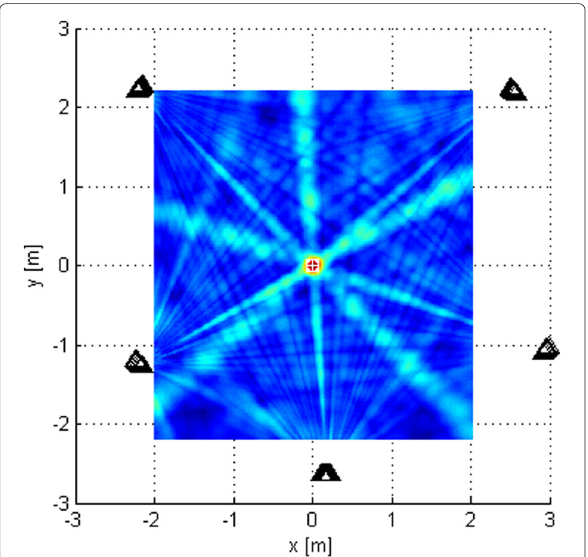
Fig. 6 The criterion function of stage 3, given by (24) with N = 1024